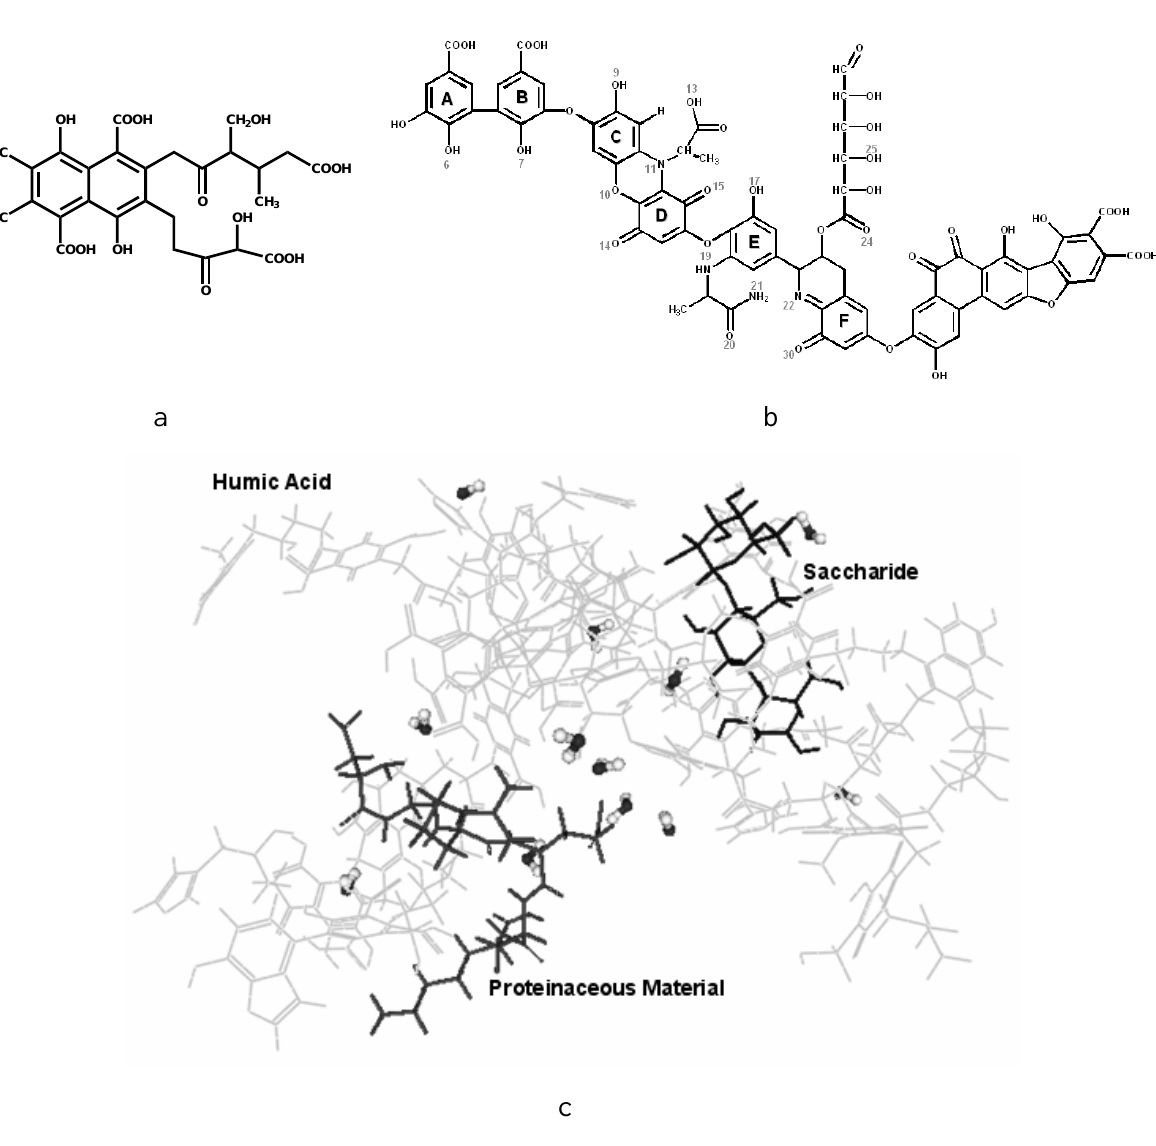
Figure 1. Structures of a) FA (Buffle’s model; b) HA (Stevenson’s model) and c) SOM (Schulten and Schnitzer’s